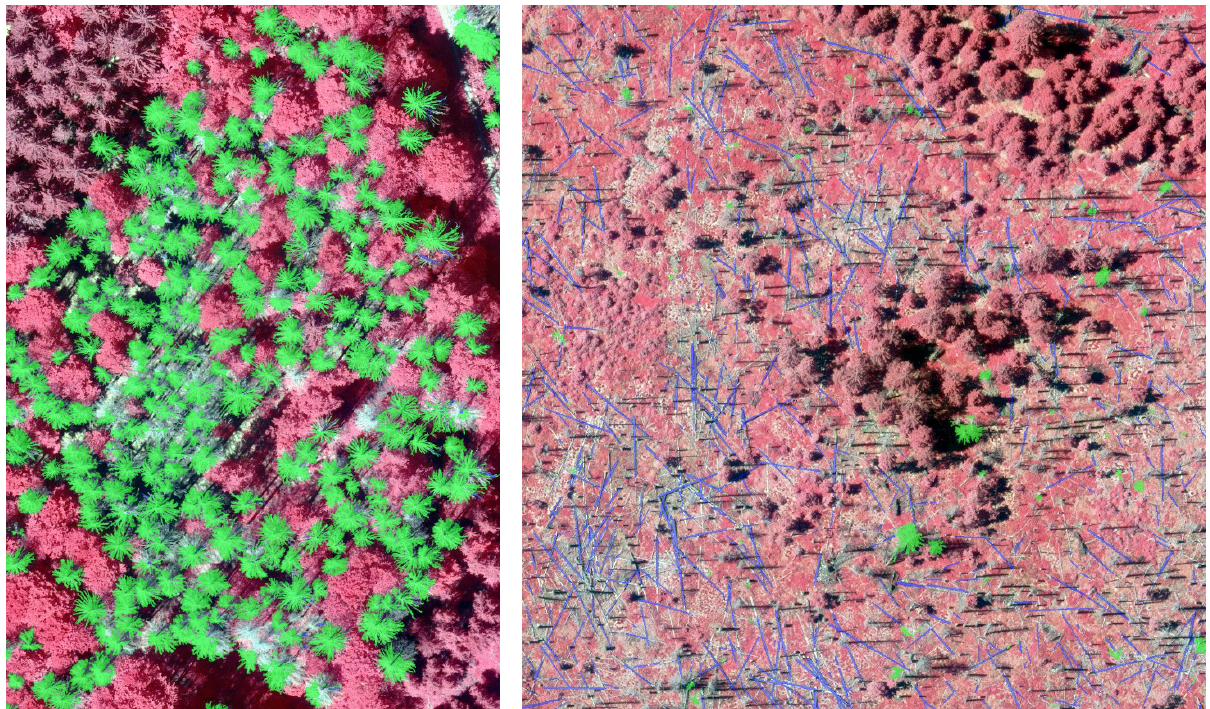
Figure. 5 Semantic segmentation of our proposed methods. Left: the green label means the standing dead trees; Right: the blue label means the fallen dead